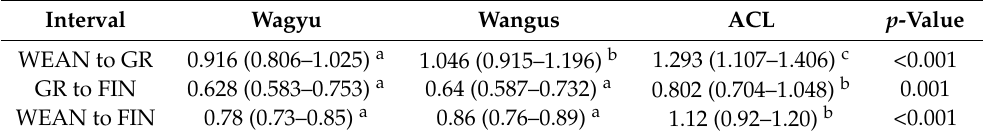
Table 5. Average daily weight gain (kg/d) of fattening steers during three intervals.